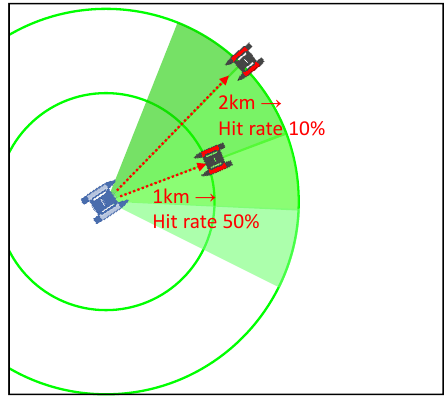
Figure A1. Hit rate of blue agent.